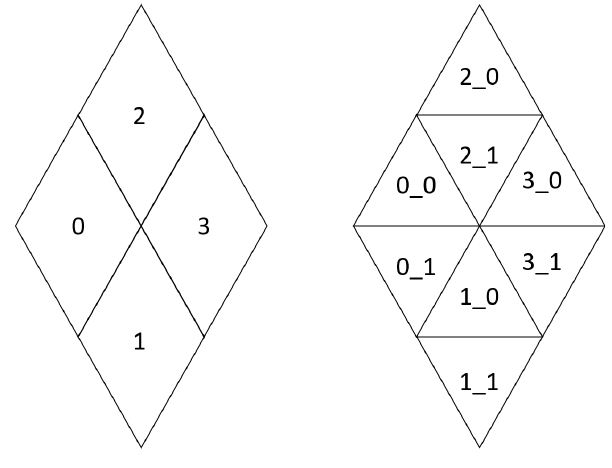
Figure 6. TRQ encoding method.